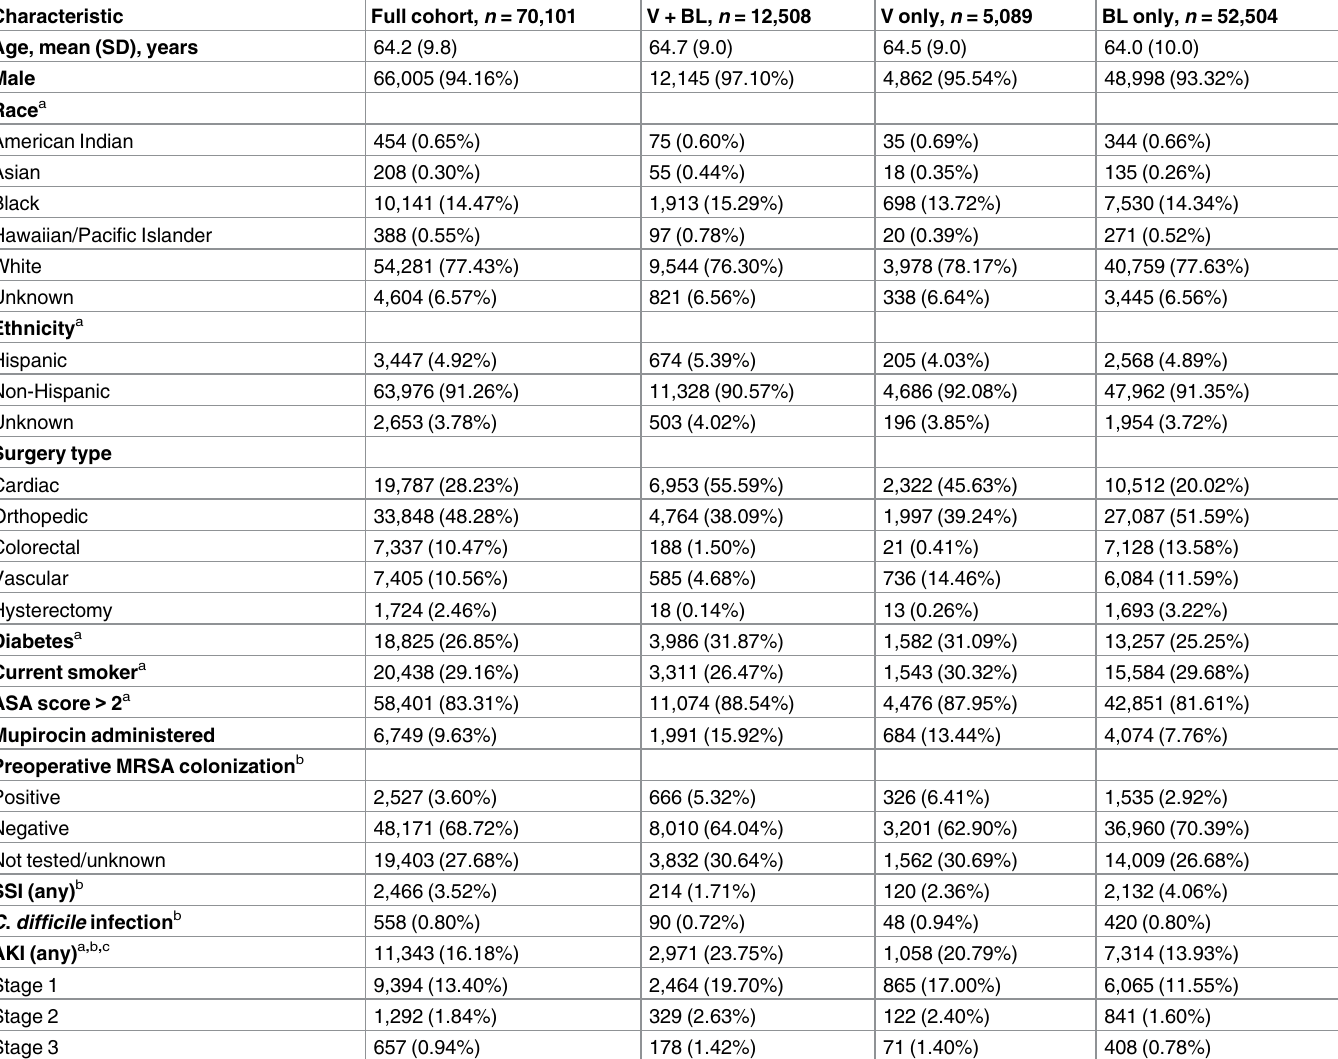
Table 1. Variable distributions among all